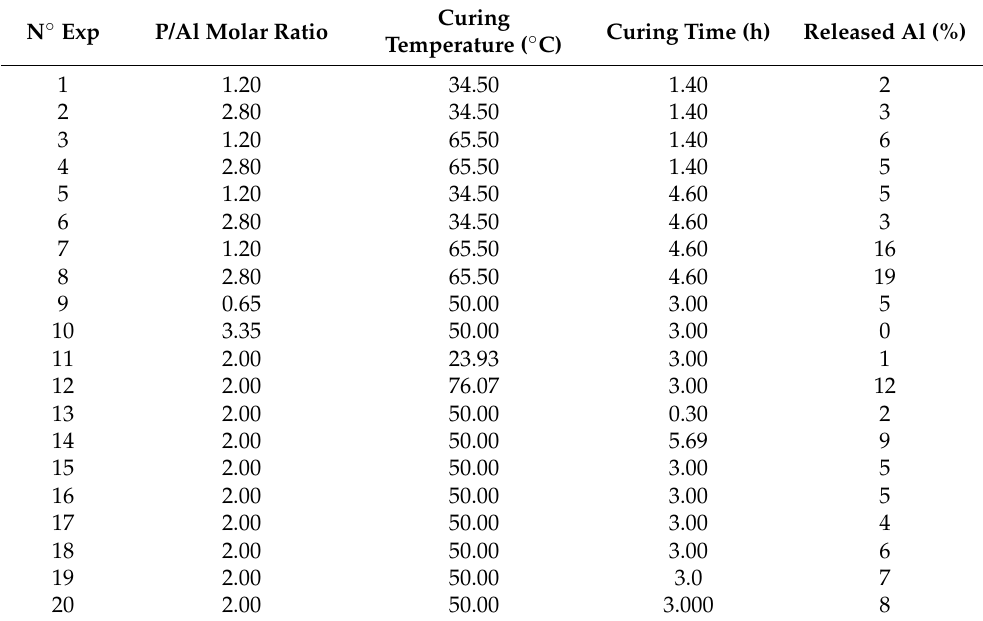
Table 7. Central composite experimental plan.